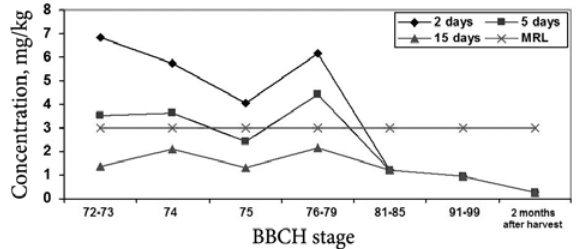
Fig. 10. Degradation of captan in Jonathan